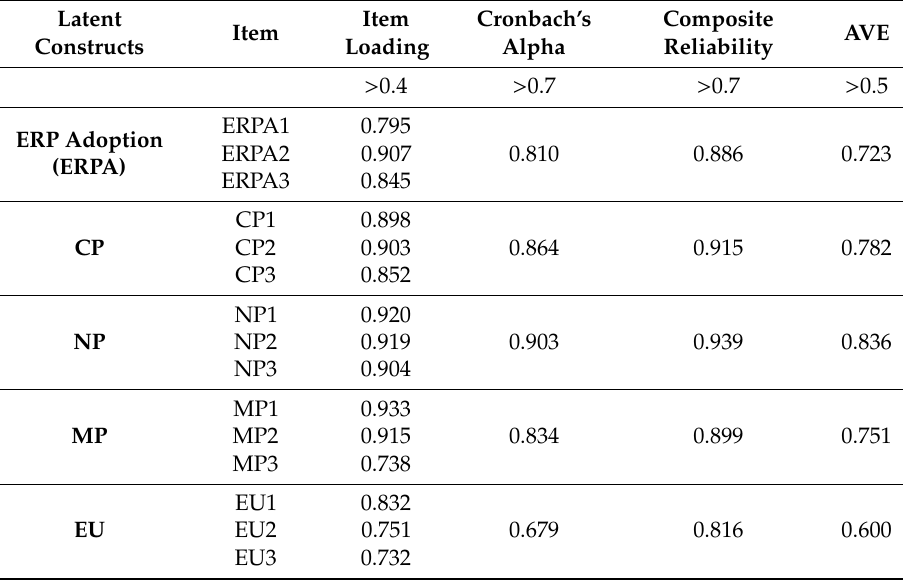
Table 2. Relevant indicators of the measurement model.